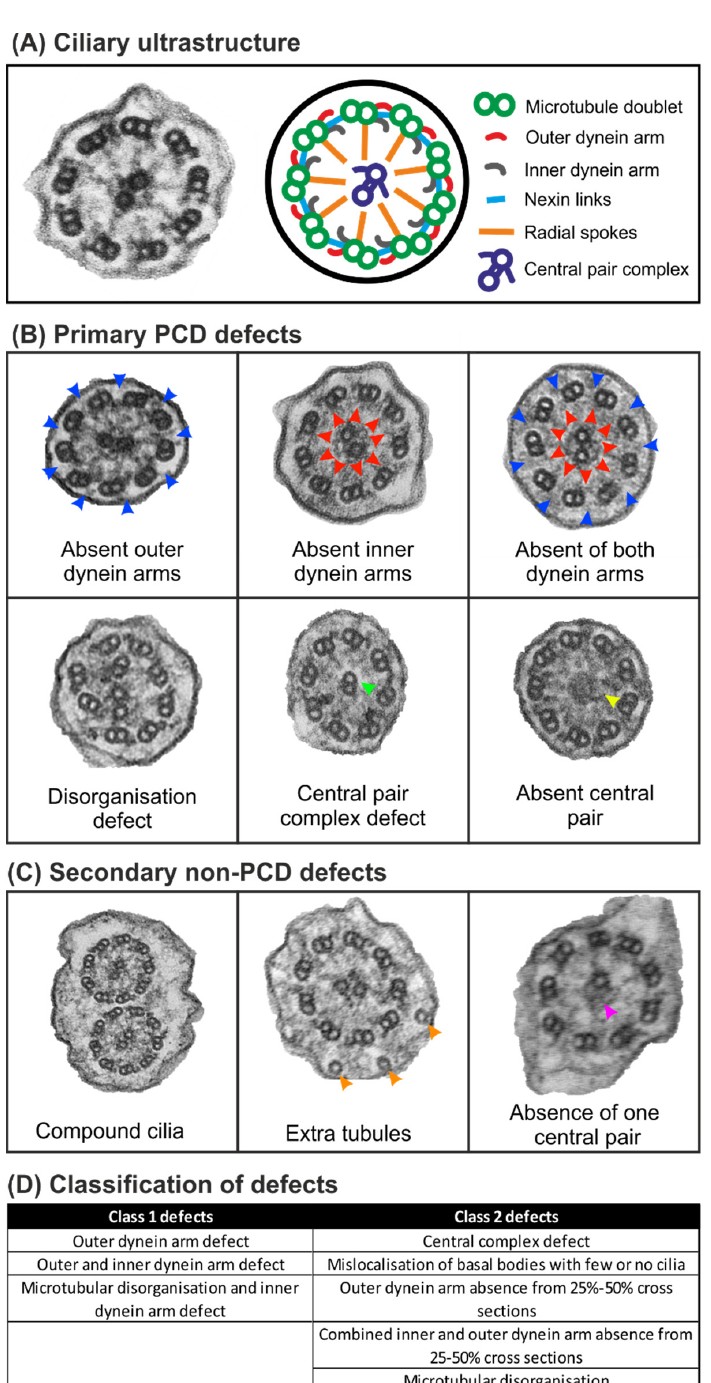
Figure 1. Normal healthy ciliary ultrastructure as well as common ciliary defects associated with primary ciliary dyskinesia (PCD) and secondary to infection. ( A ) Electron microscopy image and diagram of a cross section through a healthy respiratory epithelial cilium, highlighting the main ciliary components. ( B ) Common PCD defects, including the loss of structures or disarrangement of the cilia. The blue arrows indicate absent outer dynein arms, the red arrows indicate absent inner dynein arms, the green arrow indicates a microtubule doublet that has transposed into the centre of the cilium, and the yellow arrow indicates the absence of the central pair microtubules. ( C ) Some of the ciliary defects associated with unhealthy respiratory epithelium are caused by bacterial or viral infections. The orange arrow indicates an extra microtubule within the cilium, and the purple arrow indicates the loss